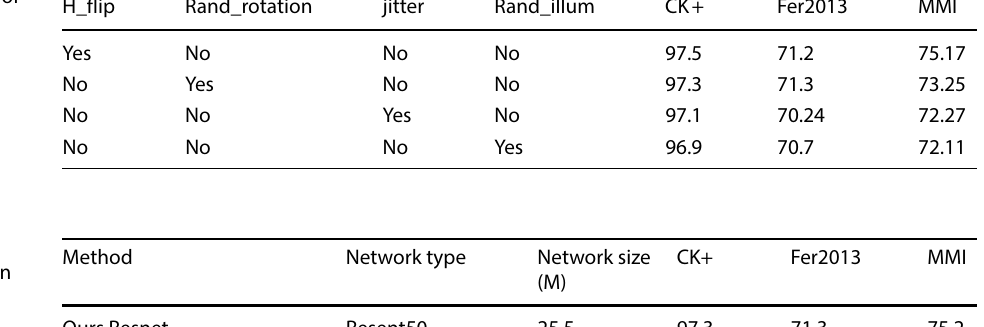
Table 6 Experimental results of Densenet data enhancement